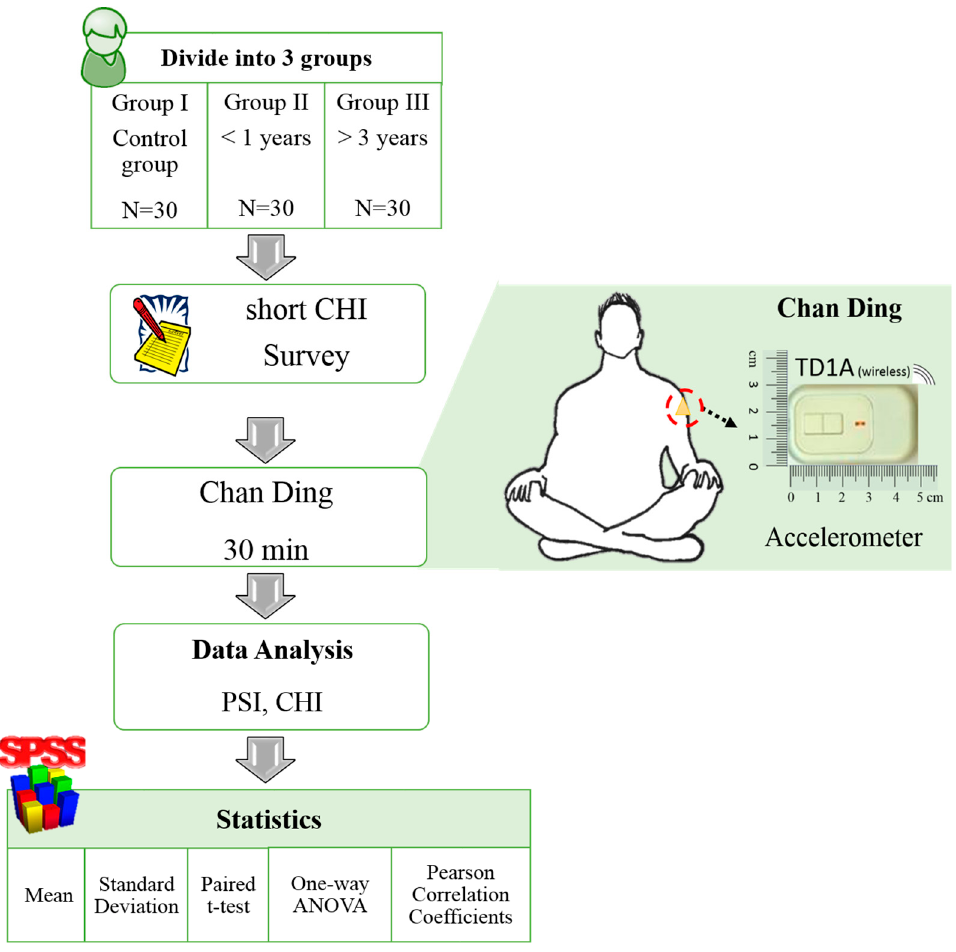
Figure 2. Flowchart of the second experiment.